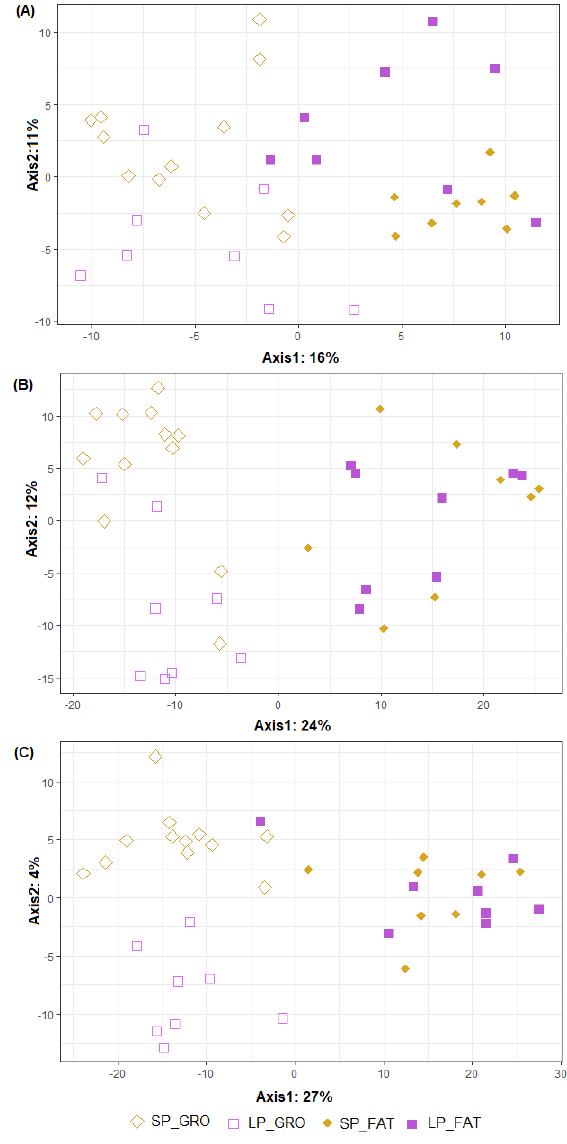
Figure 2. Graphical representation of partial least squares-discriminant analysis (PLS−DA) on microbial OTUs in ileum ( A ), cecum ( B ) and distal colon ( C ). Obtained in pigs differing in their protein intake: standard protein (SP) vs. low protein (LP) and in their production phase: growing (GRO: 28.5 kg) vs. fattening (FAT: 88.1 kg). Each point represents a different sample and a greater distance between two points infers a higher dissimilarity between them. Statistical comparisons were made between PP ( p < 0.001 for all intestinal segments), between diets ( p = 0.916, 0.433 and 0.573 for ileum, cecum and distal colon, respectively) and to test PP by diet interaction ( p = 0.239, 0.489 and 0.638 for ileum, cecum and distal colon,